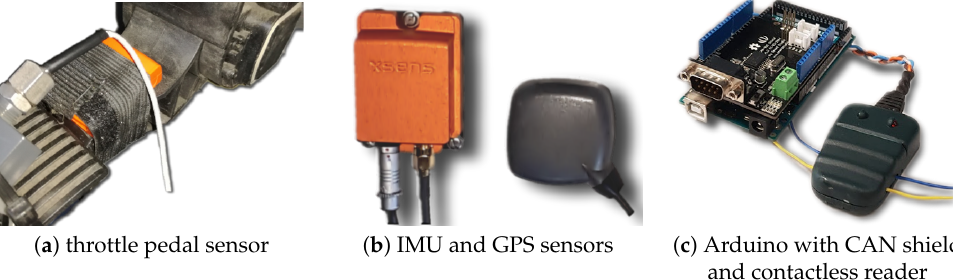
Figure 4. Sensors used for data acquisition and